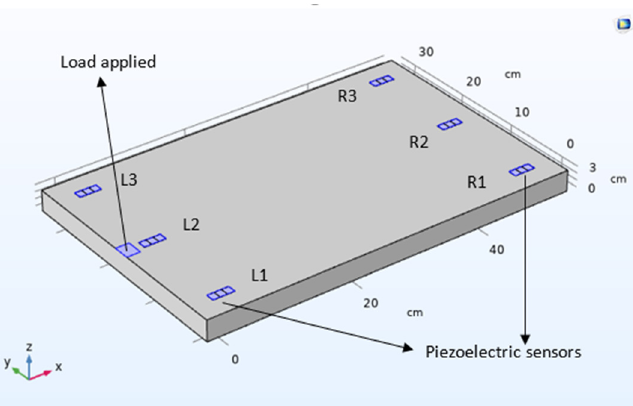
Figure 1. Structure design embedding piezoelectric sensors and load pressure.